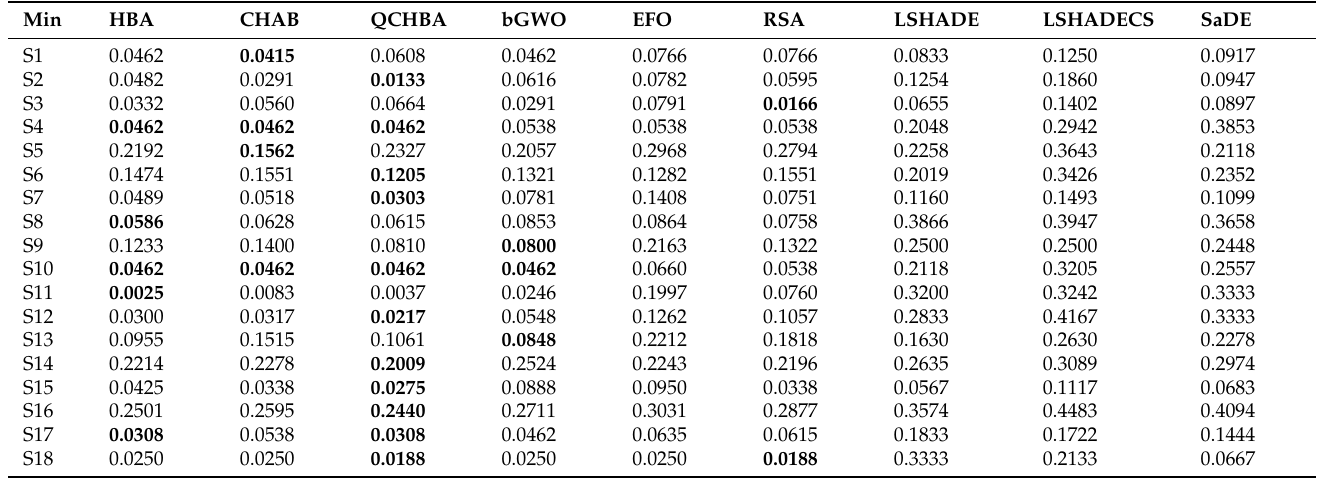
Table 4. Best fitness values generated using competitive methods.